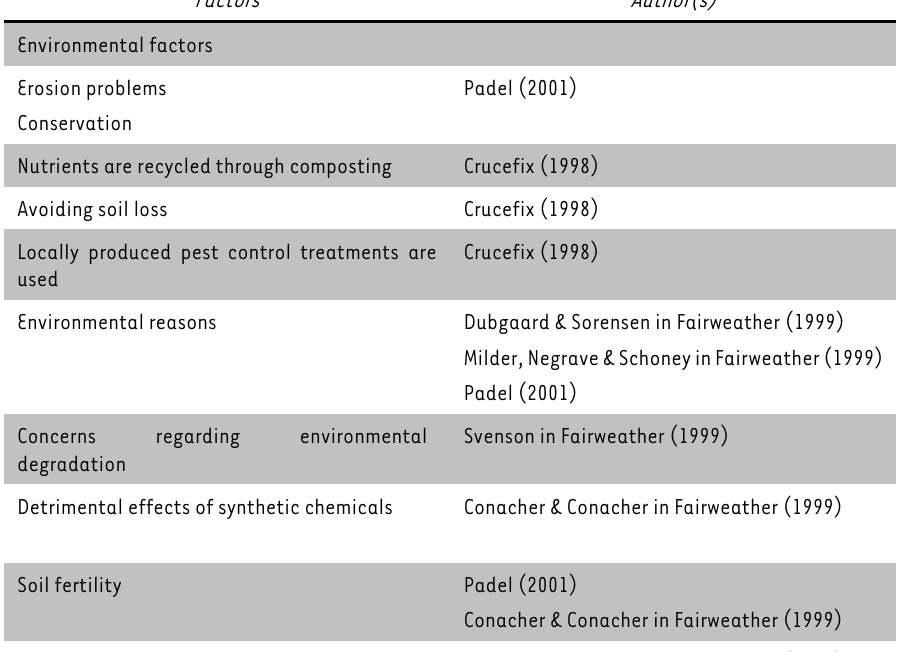
TABLE 1: Factors motivating conversion